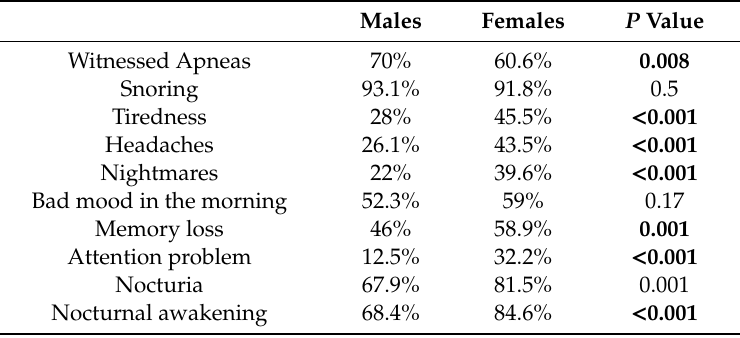
Table 5. Di ff erences in sleep apnea symptoms * between